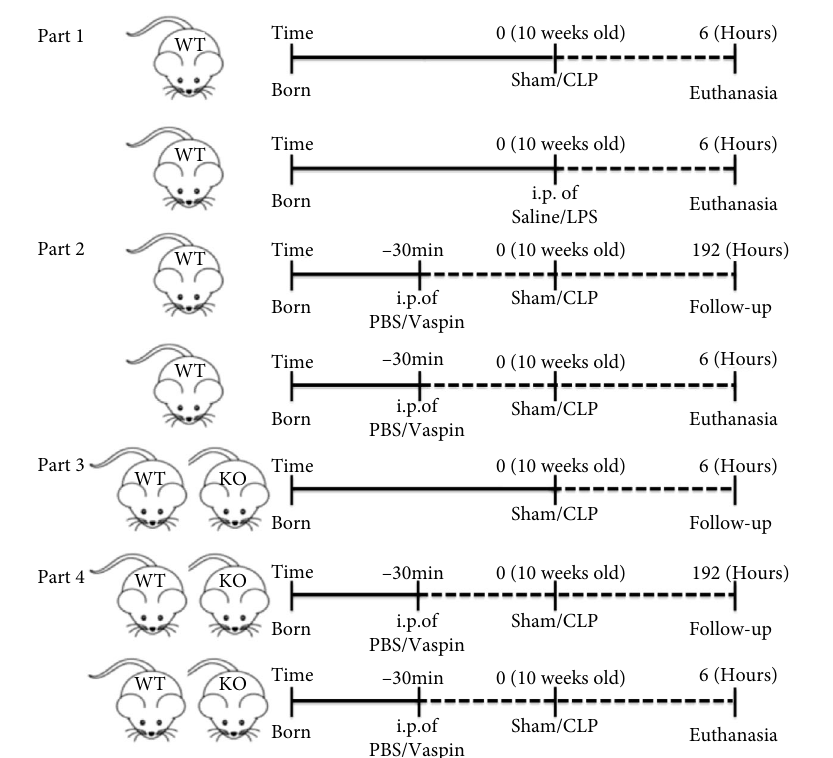
Figure 1: Establishment and pretreatment of the mouse sepsis